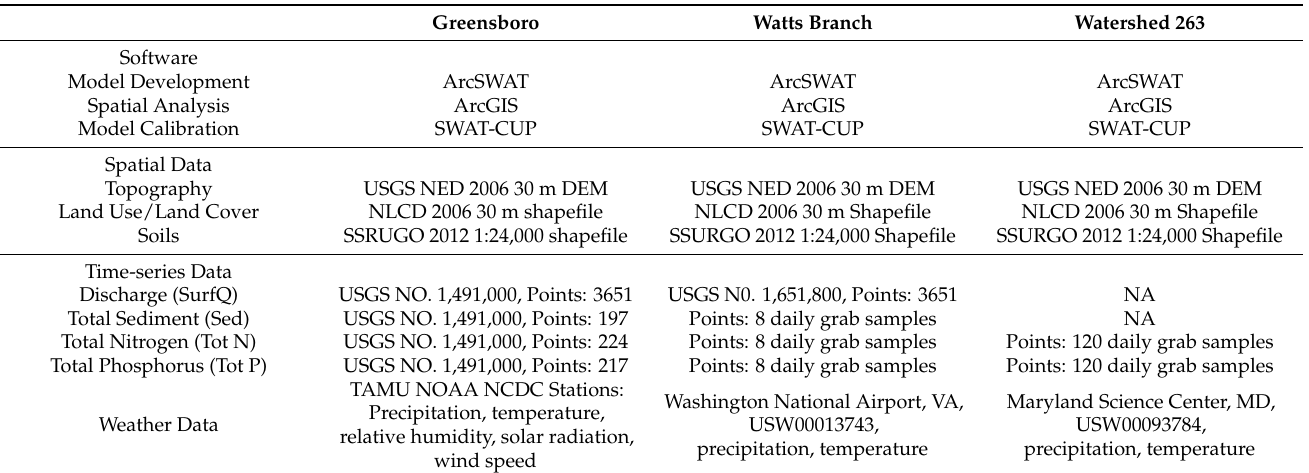
Table 1. Software and data used in the